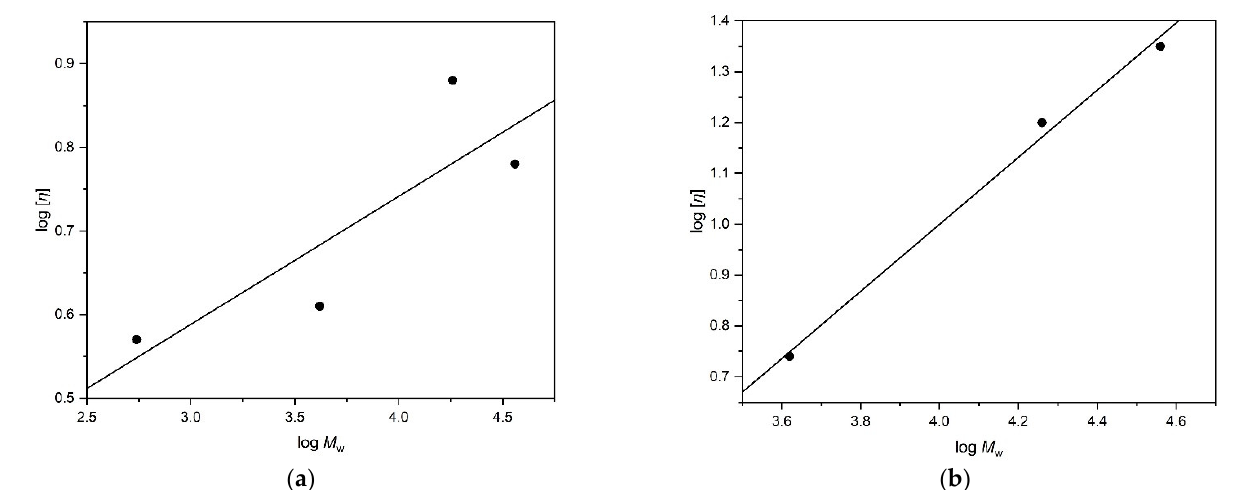
Figure 10. Mark–Houwink–Kuhn–Sakurada plots of the siloxanes in ( a ) isopropanol (a ~ 0.15) and ( b ) turpentine (a ~ 0.66) .